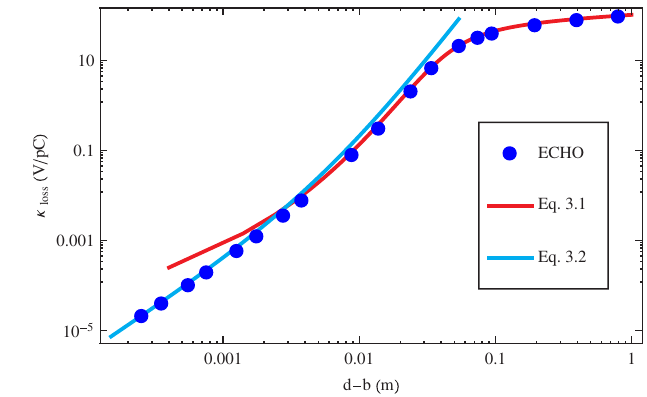
FIG. 12. (Color) For different values of g , we show the loss factor as calculated with ECHO as a function of taper length L for the collimator with parameters d ¼ 12 : 5 mm , b ¼ 6 : 25 mm , and (cid:1) ¼ 0 : 5 mm .